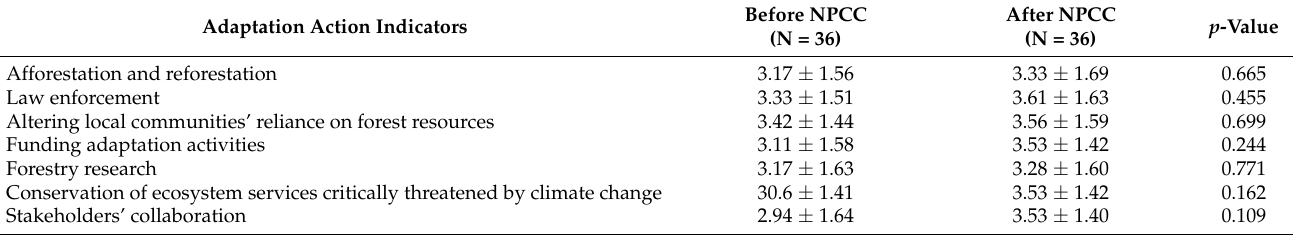
Table A2. Indicators of actions scores of the implemented policy before and after